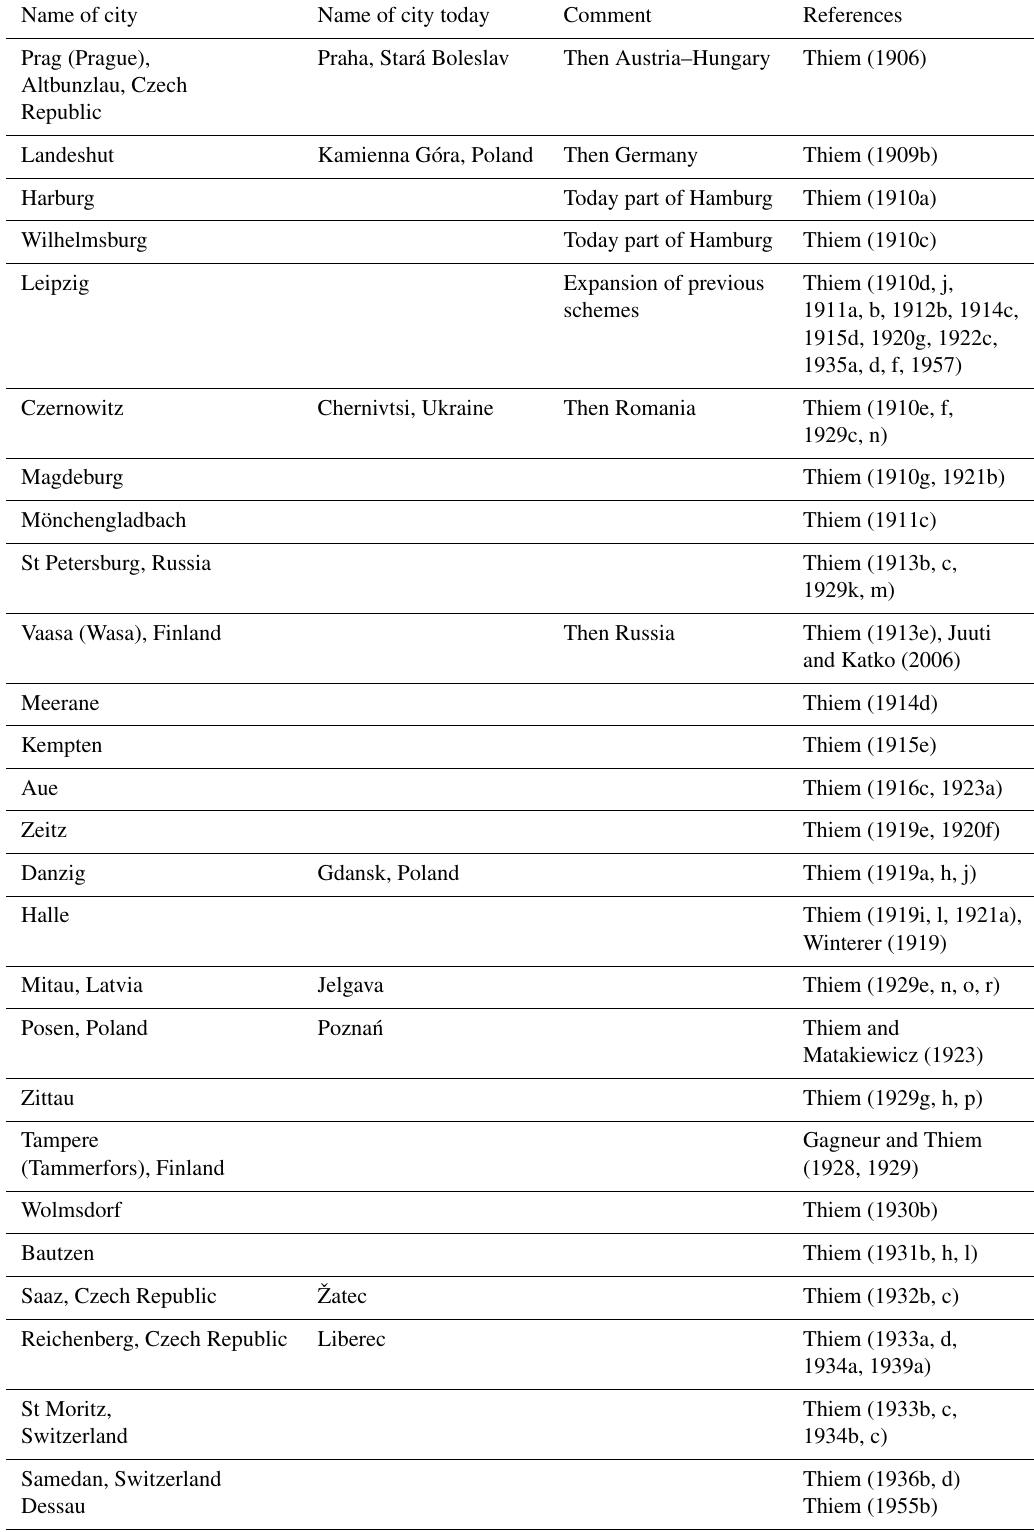
Table 2. Main water supplies planned and built by Günther Thiem (English names in